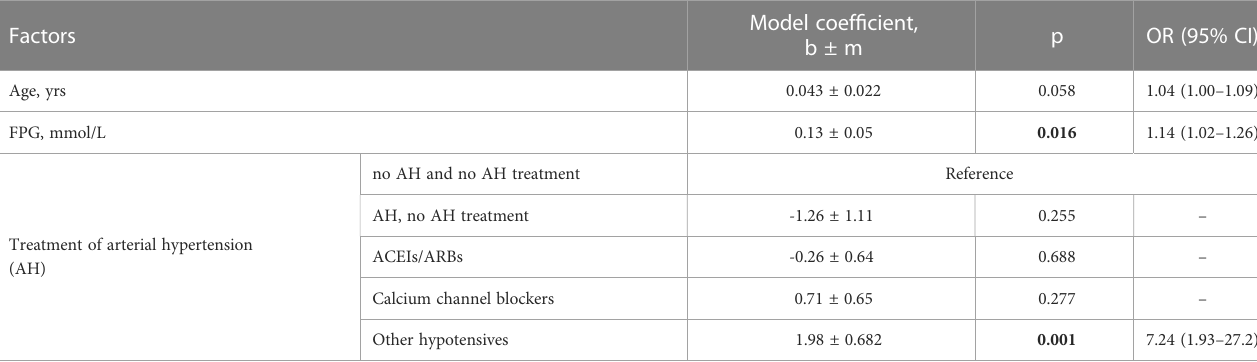
TABLE 6 Analysis of a multifactor logistic regression model for predicting the risk of death for patients with